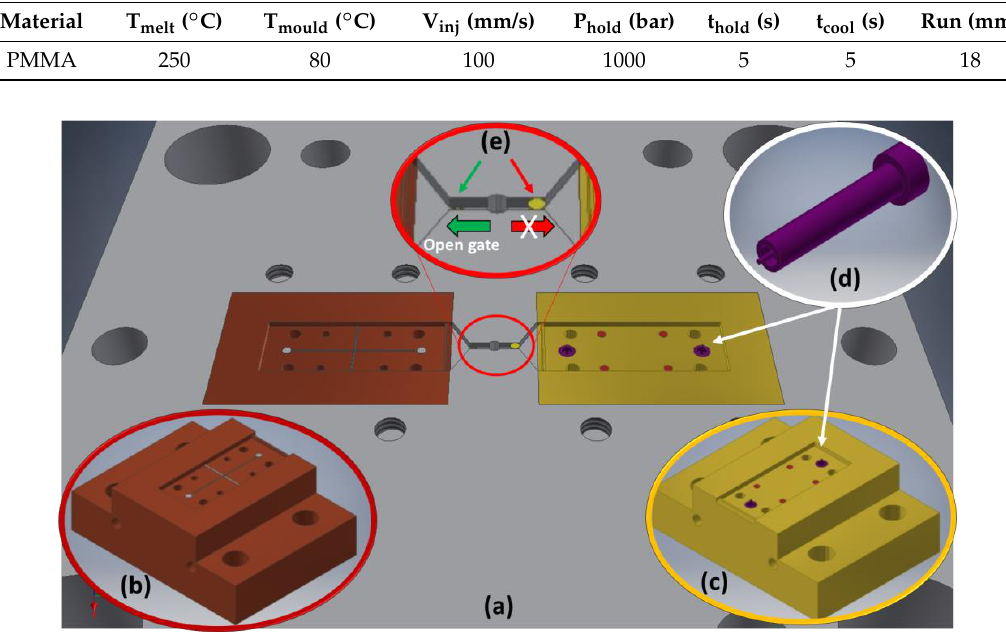
Table 1. Values for the microinjection moulding process parameters obtained from the simulations for Acryrex ® CM-211 PMMA (polymethylmethacrylate).